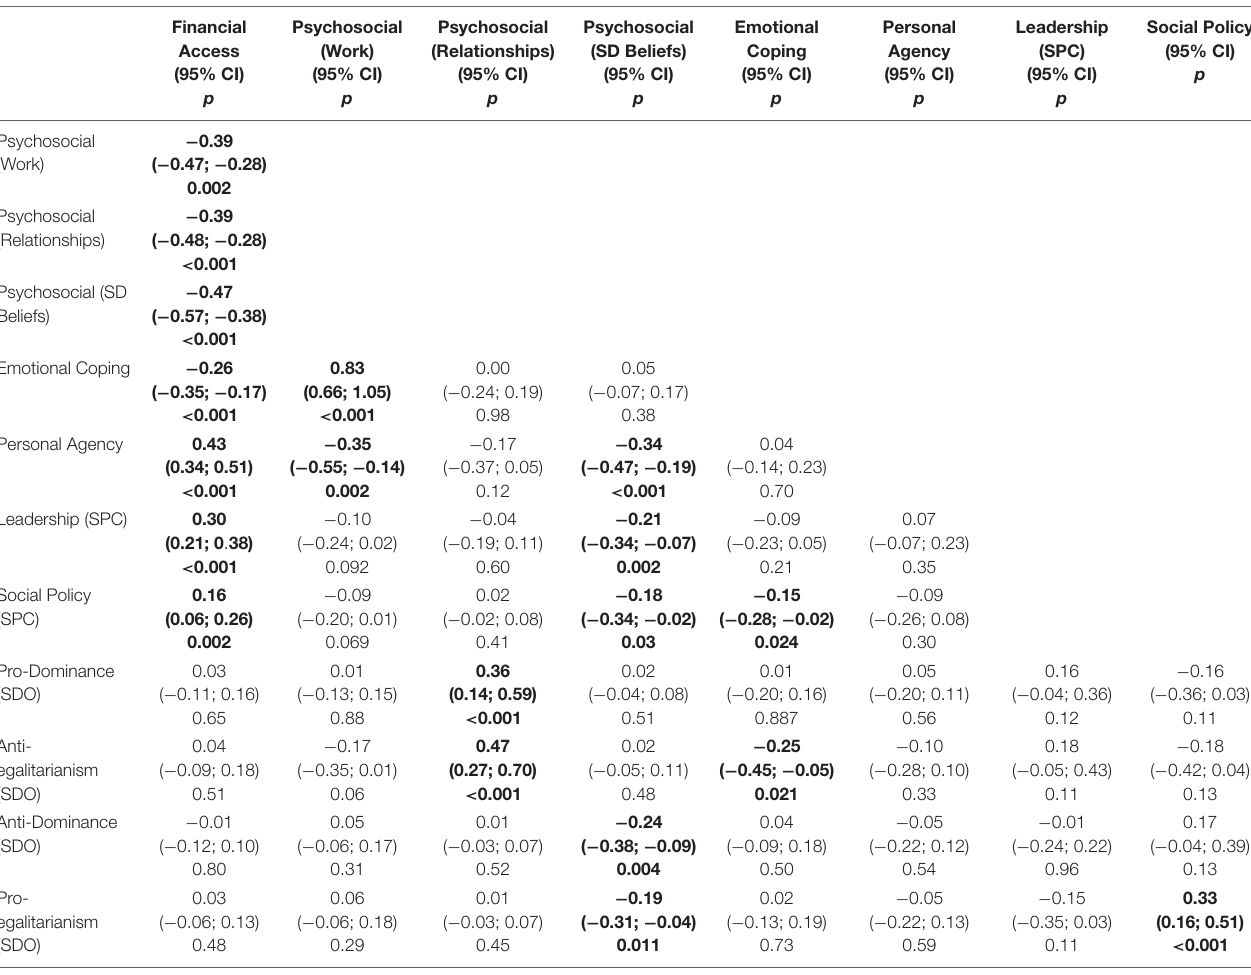
TABLE 6 | Total effects for the mediation SEM Model A.